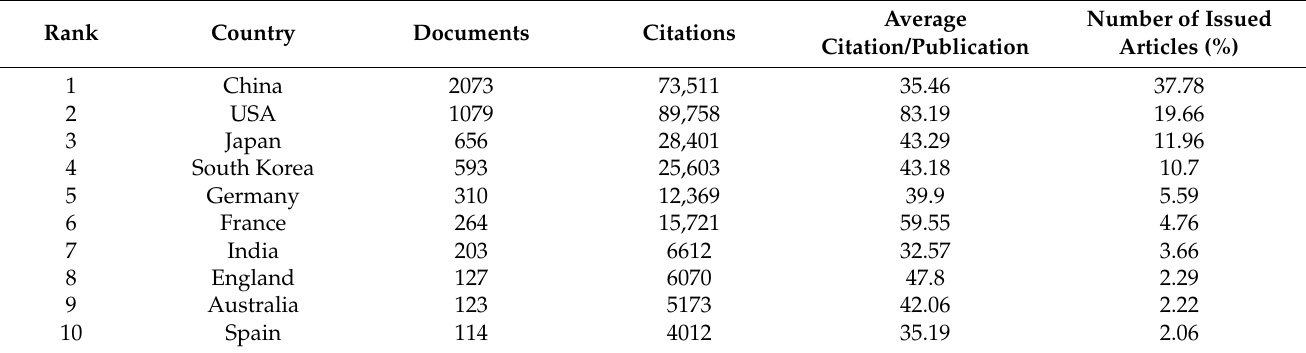
Table 1. Top 10 contributing